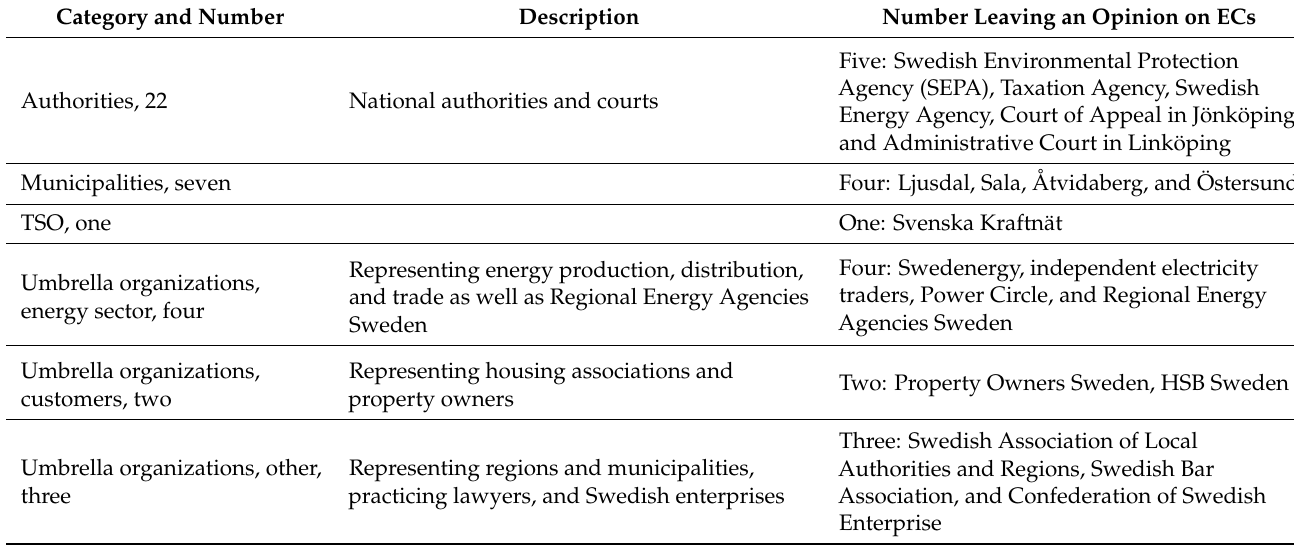
Table 2. Summary of the actors submitting an